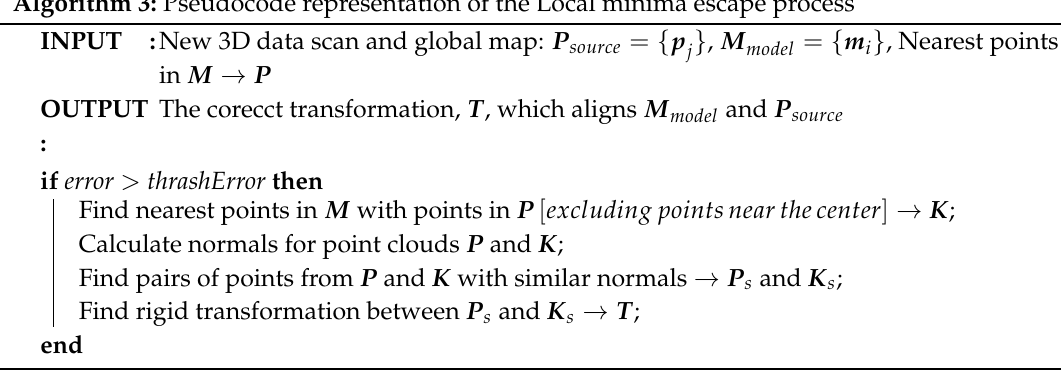
Figure 6. Surface normal estimation of an example dataset. ( a ) raw data scan; ( b ) vectors ( x , y , z ) are represented by colors blue, green, and red, respectively (Dataset: Military-base Marche–en–Famenne). Algorithm 3: Pseudocode representation of the Local minima escape